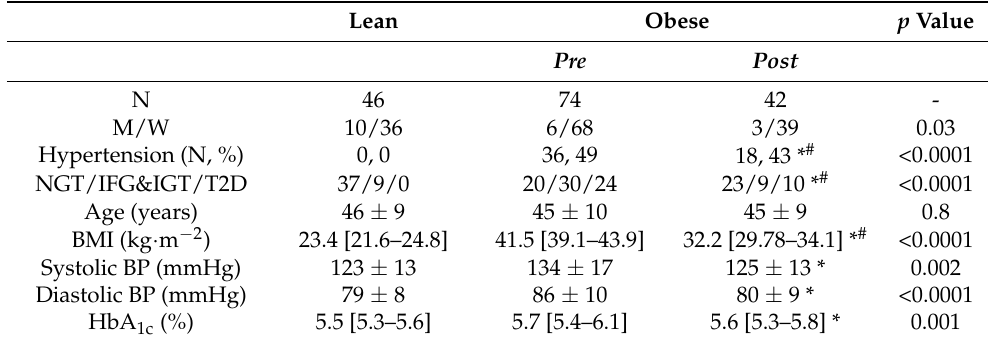
Table 1. Anthropometric and biochemical characteristics of the study participants §